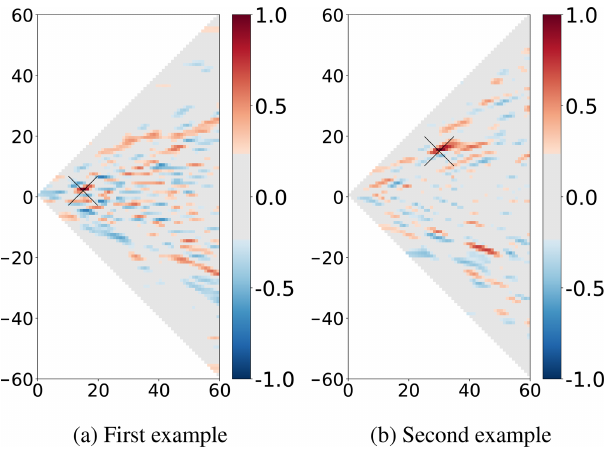
Figure 5. Two examples of ensemble correlation for the prior en- semble (SSH) in the spectral domain, according to the degrees l ∈ [ 0 , 60 ] in the abscissa and m in the ordinate; see Eq. (2). The two different reference points are indicated by black crosses. Light grey colour corresponds to non-significant values of ensemble cor- relations for an ensemble of N = 69 members (smaller in absolute value than 0 . 2367 with significance threshold at